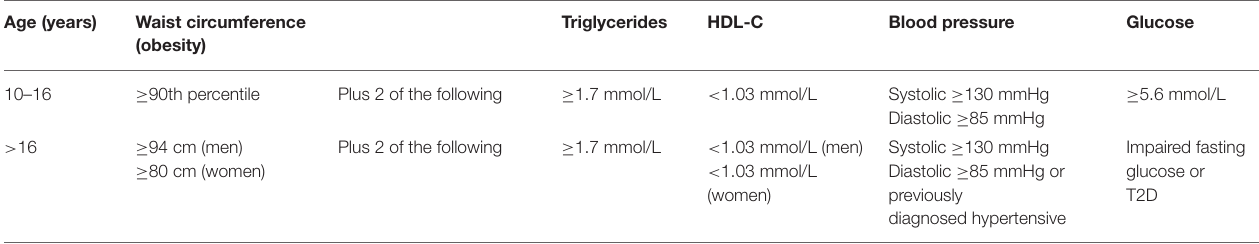
TABLE 1 | International diabetes federation definition of metabolic syndrome in